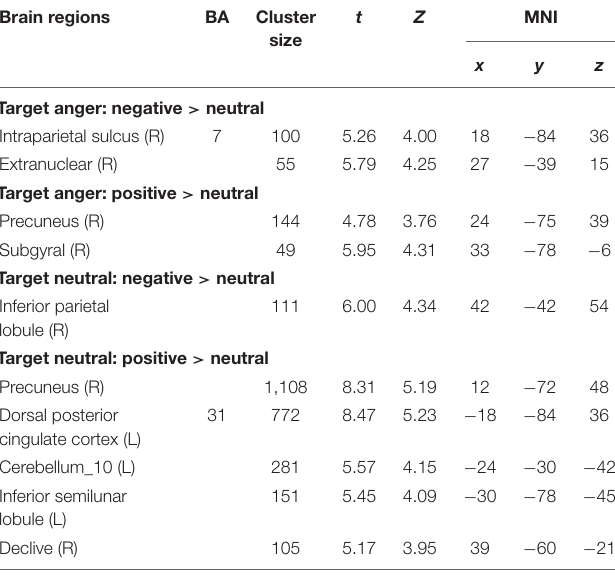
TABLE 2 | Coordinates in Montreal Neurologic Institute (MNI) space and associated t scores showing the BOLD differences for the contrast of emotional contexts followed by the same